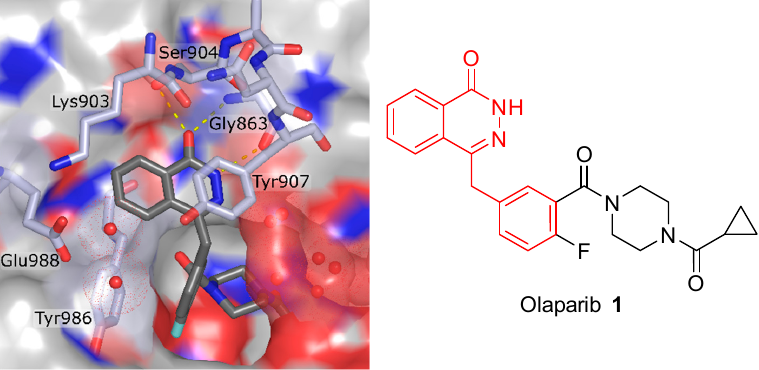
Figure 1. Olaparib 1 bound in the PARP-2 binding site (4tvj) [41].